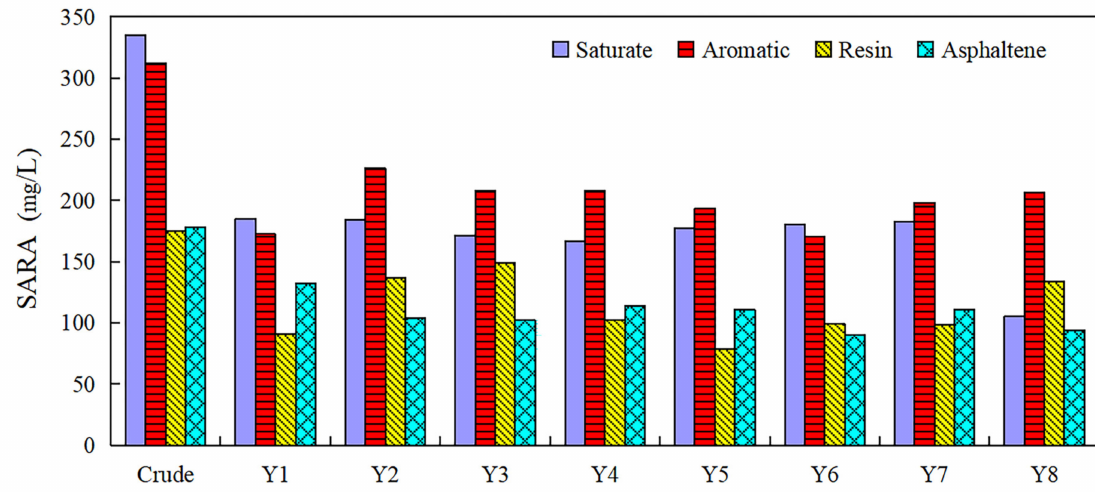
Figure 4. SARA fractions extracted from the initial heavy oil sample and samples after biodegradation.